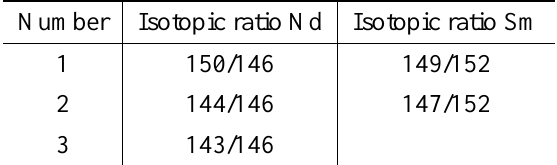
Isotopic ratios used for isotope dilution calculations in this